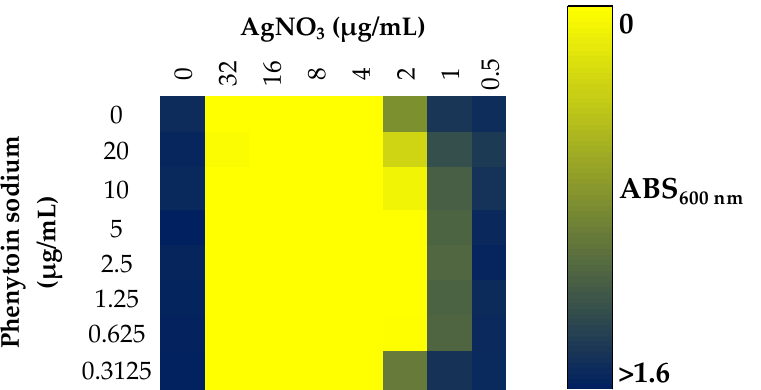
Figure 3. Synergy between silver nitrate and phenytoin sodium against planktonic state of ATCC27853. Blue indicates bacterial growth, while yellow indicates the absence of bacterial growth.